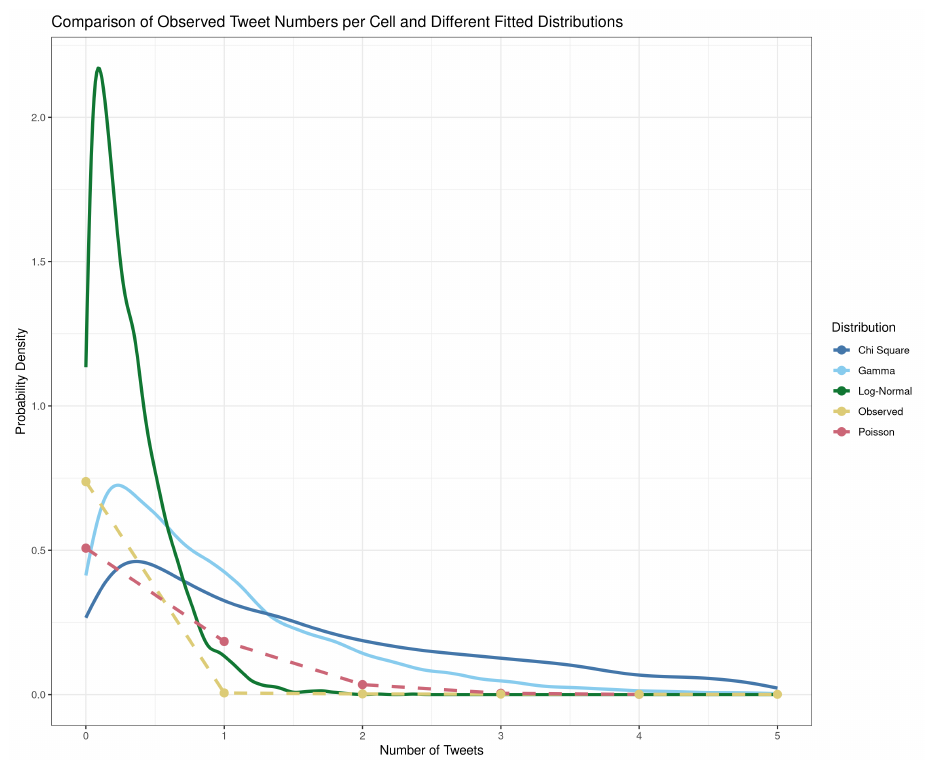
Figure 3. Probability densities of observed and fitted tweet counts. The observed counts and Poisson fit are discrete, the other curves are